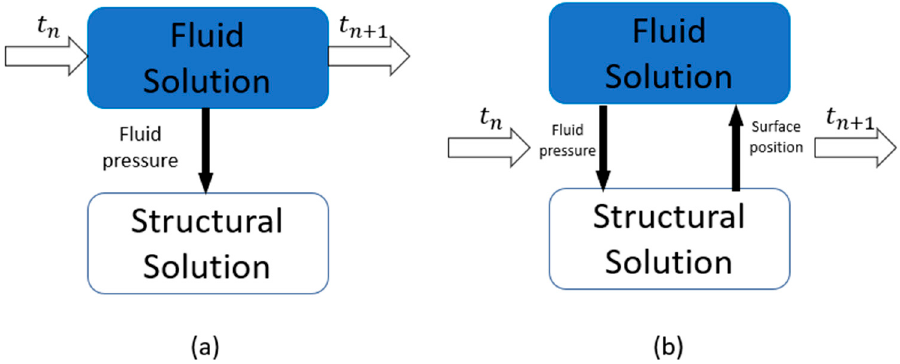
Figure 1. FSI coupling methods: ( a ) one-way, ( b ) two-way .